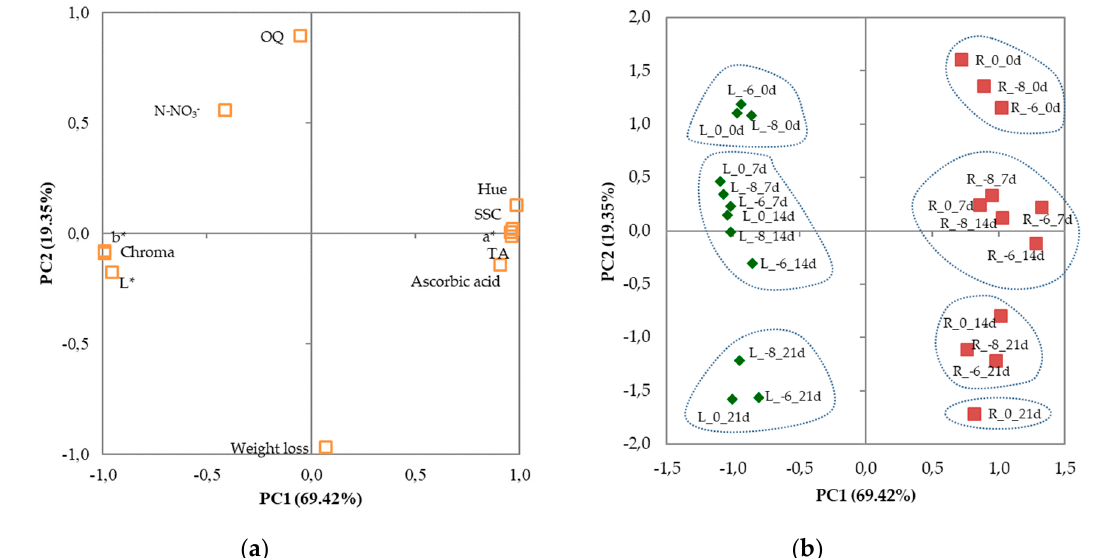
Figure 3. Plot of ( a ) loadings (quality characteristics of minimally processed leaf lettuce and rocket during 21 d of storage at 4 °C) and ( b ) scores (trials) formed by the two principal components from the Principal Component Analysis. L_0, L_ − 8, and L_ − 6: lettuce (green rhombuses) cultivated in nutrient solutions with 0, 10 − 8 and 10 − 6 M GA 3 , respectively; R_0, R_ − 8, and R_ − 6: rocket (red squares) cultivated in nutrient solutions with 0, 10 − 8 and 10 − 6 M GA 3 , respectively; _0d, _7d, _14d, and_21d: days of storage at 4 °C.